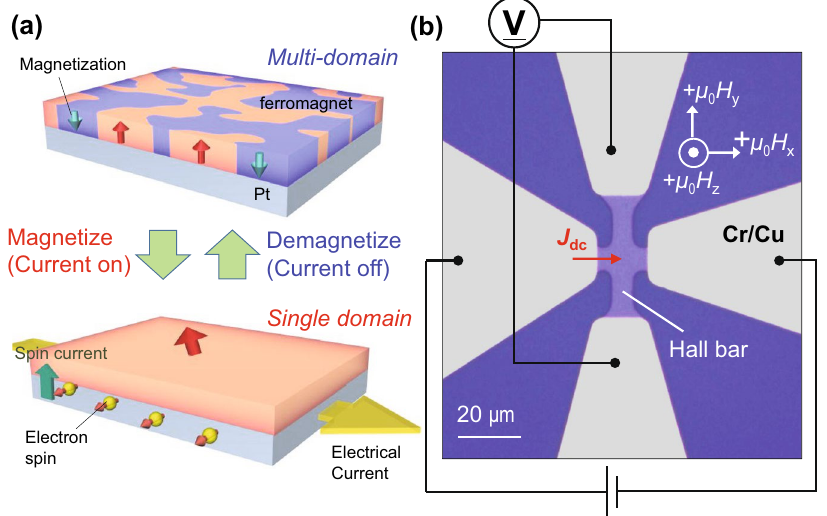
Figure 1. Current-induced magnetization process and schematic of device structure. ( a ) When electrical current is injected into thin ferromagnet/Pt layered structure, the system is gradually magnetized and finally, single magnetic domain structure appears. ( b ) Device image taken by an optical microscope. A Pt/Co/Pd Hall bar structure with 5 μ m width is prepared. Grey regions indicate Cr/Cu electrodes. Current source and voltage meter are connected as shown in the figure. Directions of external magnetic fields ( μ 0 H x , μ 0 H y and μ 0 H z ) are indicated by white arrows. The sign of electrical current is defined as positive when the current flows from left to